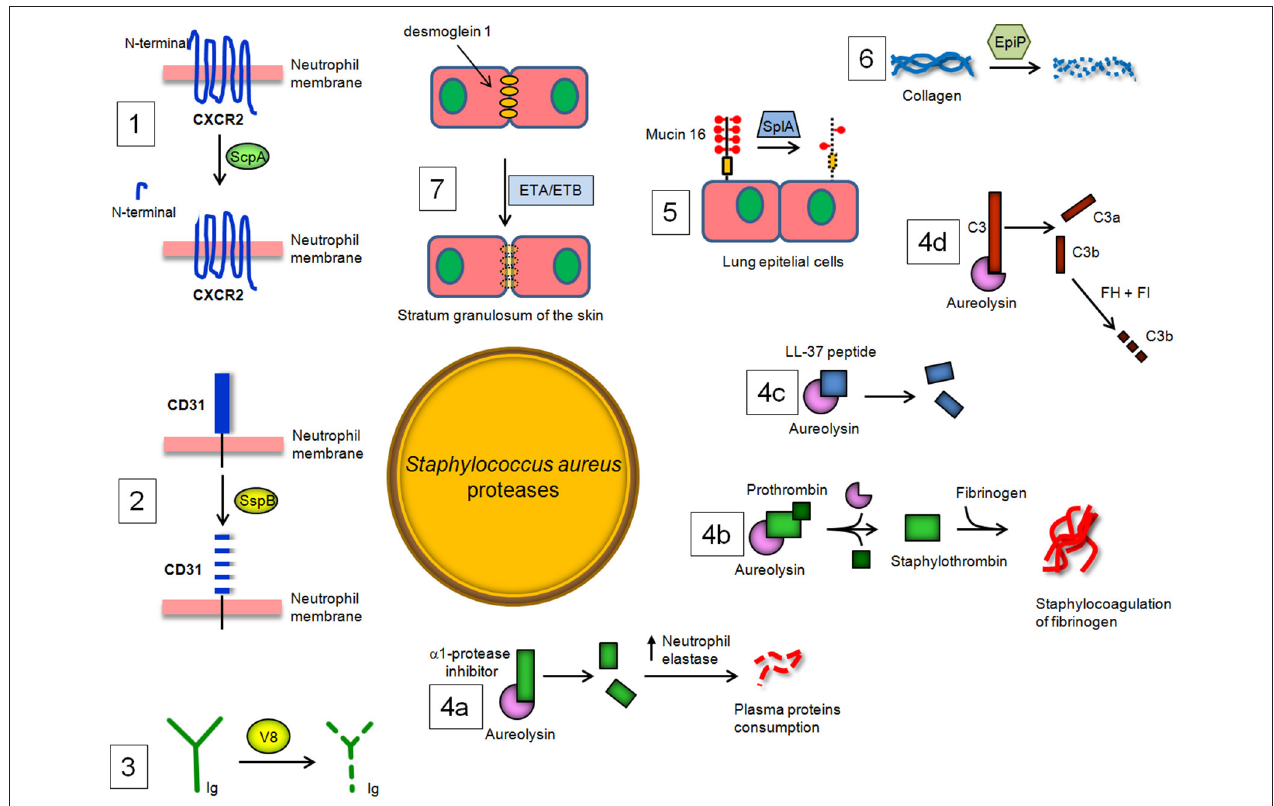
FIGURE 3 | S. aureus proteases and their enzymatic targets in the host. (1) Staphopain A (ScpA) cleaves the N-terminal domain of CXC receptor 2 (CXCR2) and impairs binding of CXC chemokines and consequent neutrophil activation and chemotaxis, while (2) Staphopain B (SspB) cleaves CD31, a member of the immunoglobulin superfamily, and dampens the functionality of neutrophils. (3) The cleaving of immunoglobulin classes by V8 protease leads to the avoidance of an immunological response and uncouples the ability of antibodies to link cell-surface antigen to immune effector cells. (4a) Aureolysin (Aur) cleaves and inactivates the α -1 protease inhibitor, resulting in deregulation of host elastase. Aur also (4b) activates prothrombin to thrombin and induces staphylocoagulation and (4c) neutralizes antibacterial peptide LL-37. Lastly, Aur (4d) can cleave C3, which compromises bacterial opsonization because the cleavage product C3b is promptly degraded by a complex of factor H and factor I. (5) SplA, a protease belonging to the Spls, is able to degrade mucin 6 on the surface of lung epithelial cells, promoting S. aureus colonization of subepithelial tissue. (6) Degradation by EpiP of collagens, essential components of the connective tissue, and (7) disruption by exfoliative toxin A (ETA) and B (ETB) of desmoglein-1, a desmosomal adhesion molecule that mediates intercellular adhesion in the stratum granulosum of the skin, also contributing to the spreading of S. aureus infection in the host